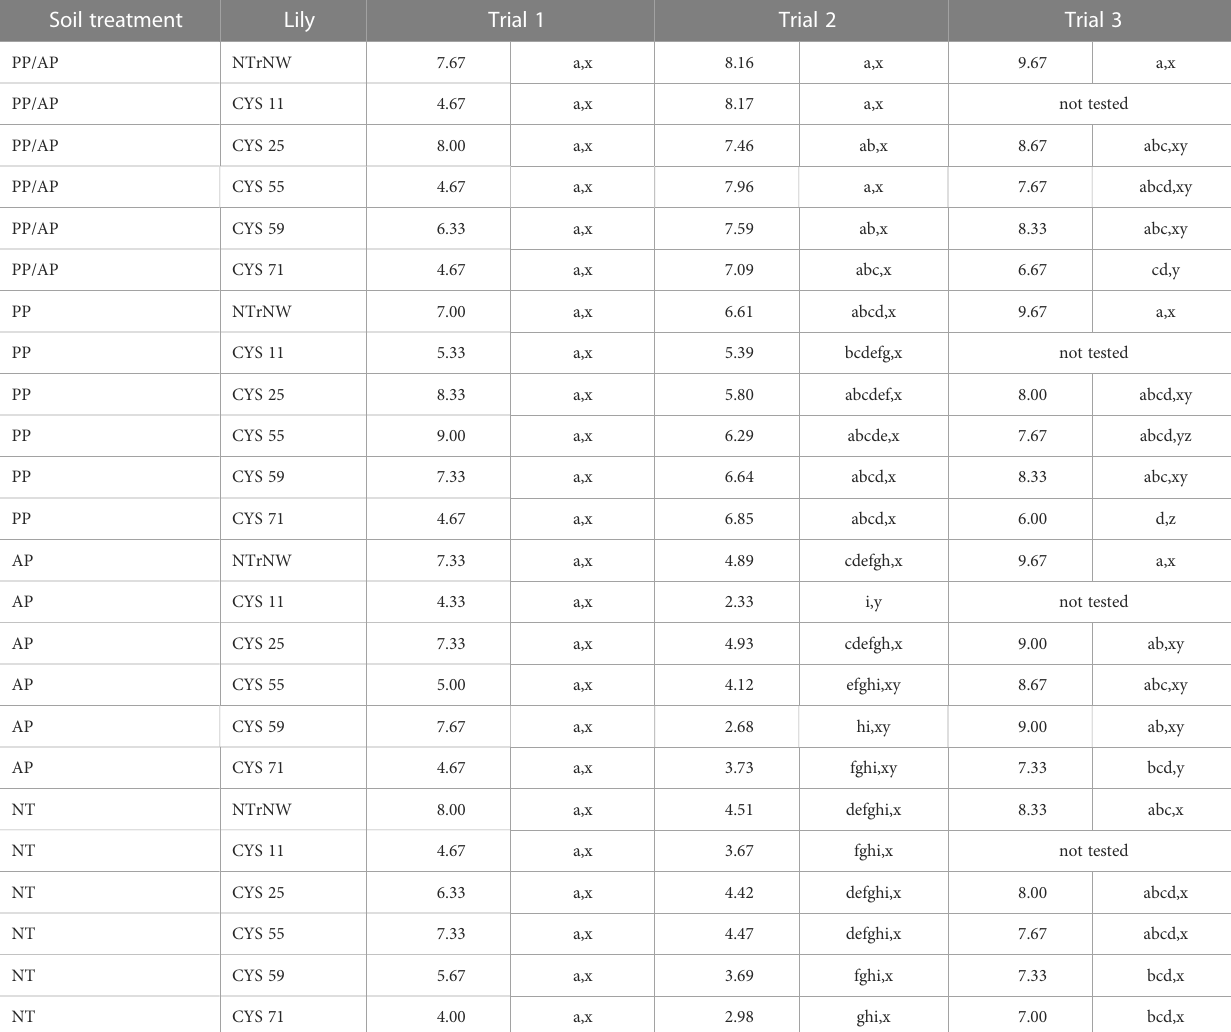
TABLE 5 Basal root visual rating at harvest in fi eld trials conducted at the Easter Lily Research Foundation Research Station in Brookings, OR, USA in soil naturally infested with lesion nematode ( Pratylenchus penetrans ). Soil treatment Lily Trial